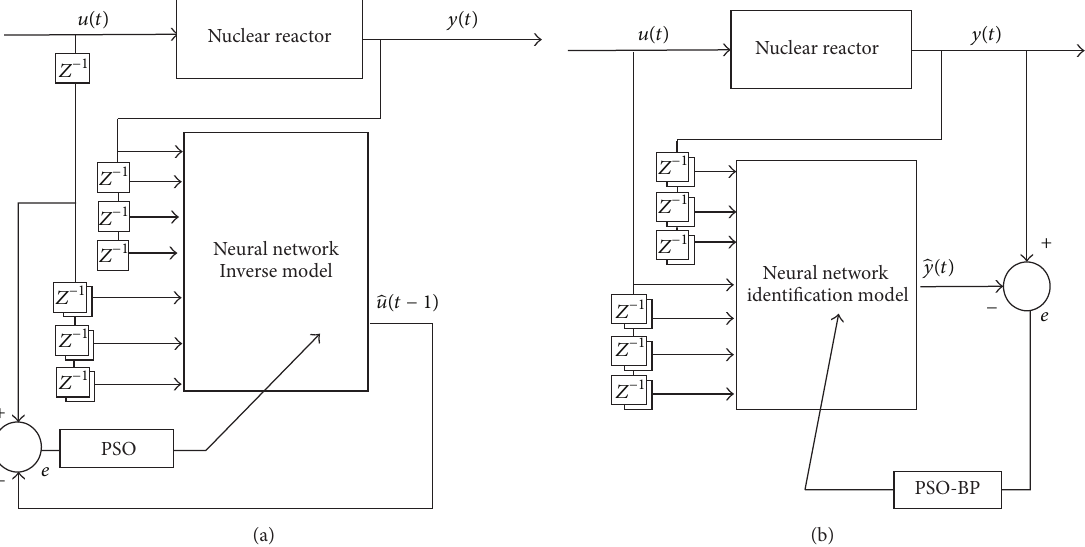
Figure 5: The block diagram of (a) inverse model training and (b) identification model